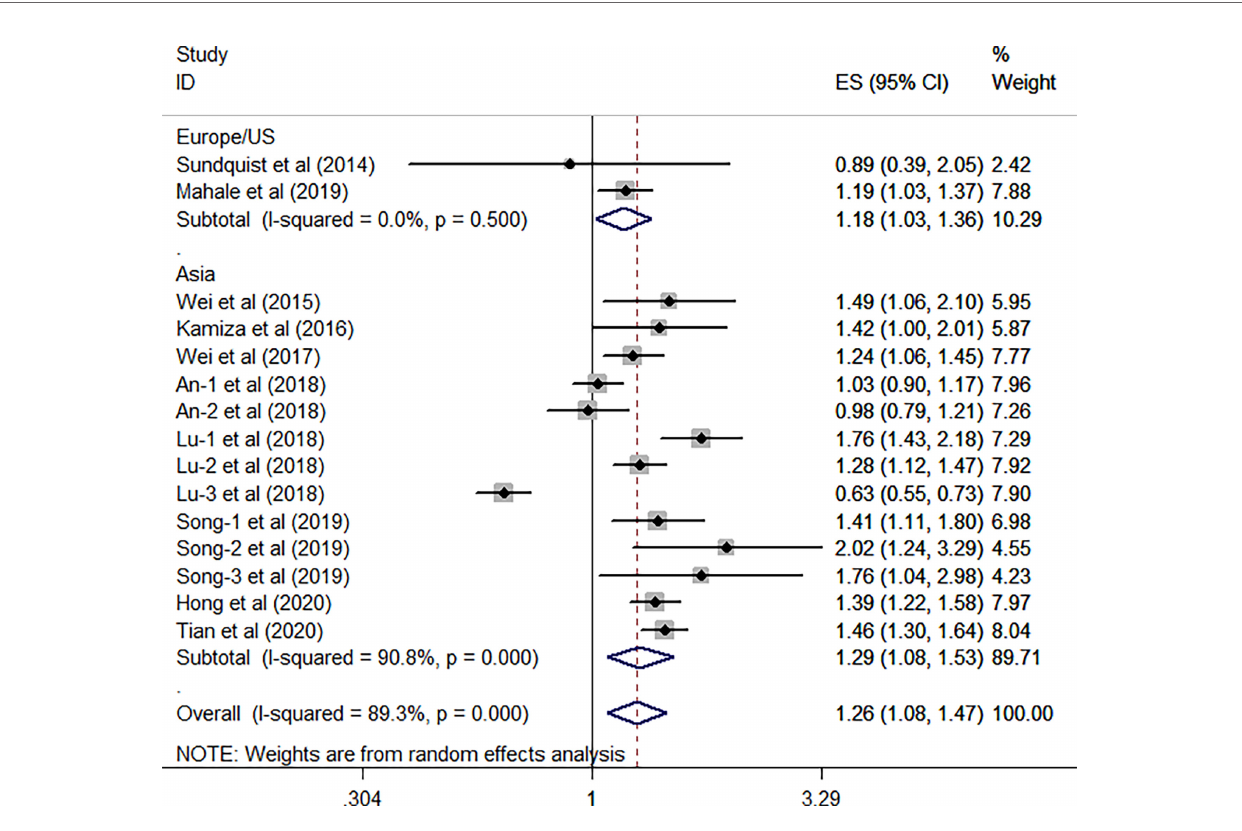
FIGURE 4 | Forest plots of the subgroup analysis (research areas) on the association between HBV and gastric